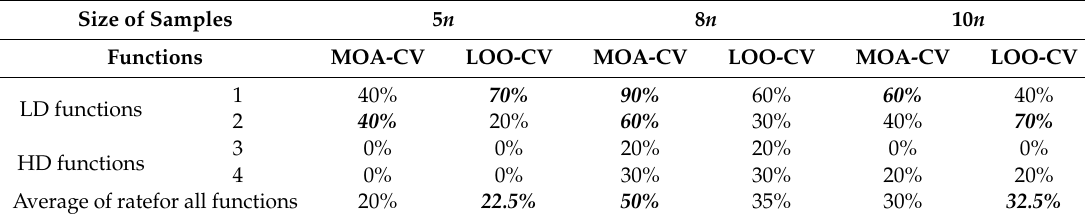
Table 7. Accurate rate of removing worst